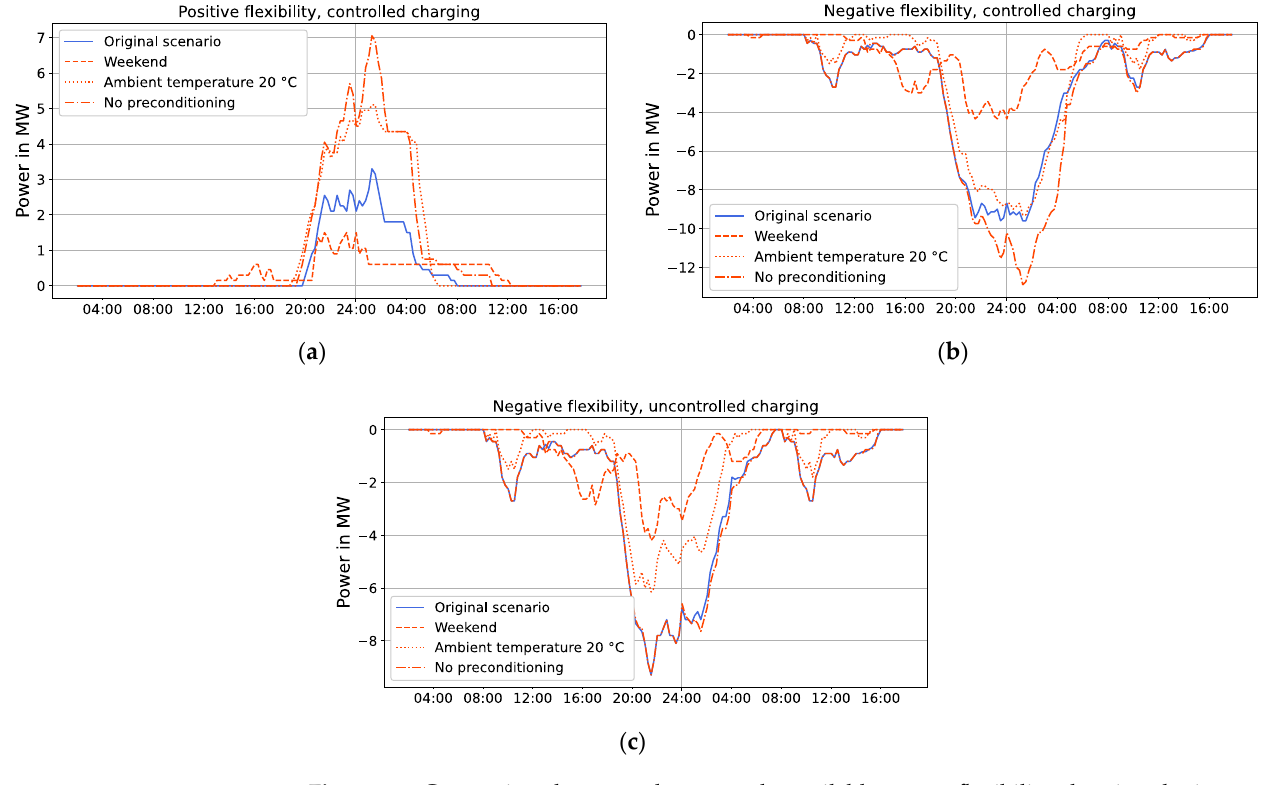
Figure 12. Comparison between the currently available power flexibility showing the impact of timeline (working day or weekend), ambient temperature, and electrical preconditioning for the case of ( a ) positive flexibility with controlled charging, ( b ) negative flexibility with controlled charging, and ( c ) negative flexibility with uncontrolled charging.